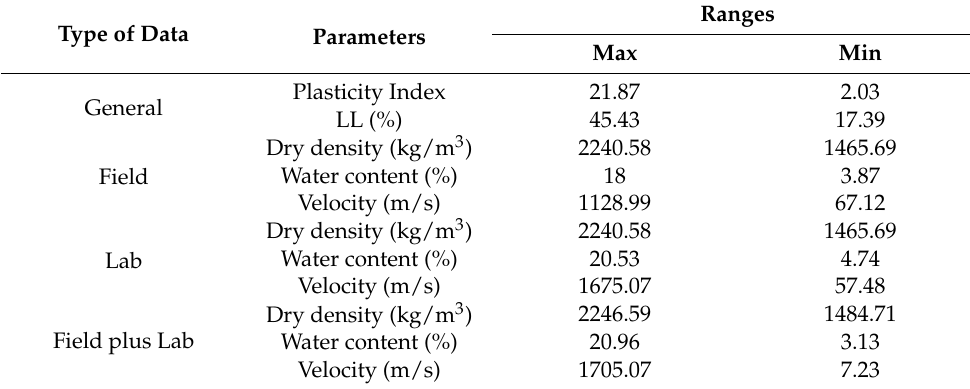
Table 2. Parameters and